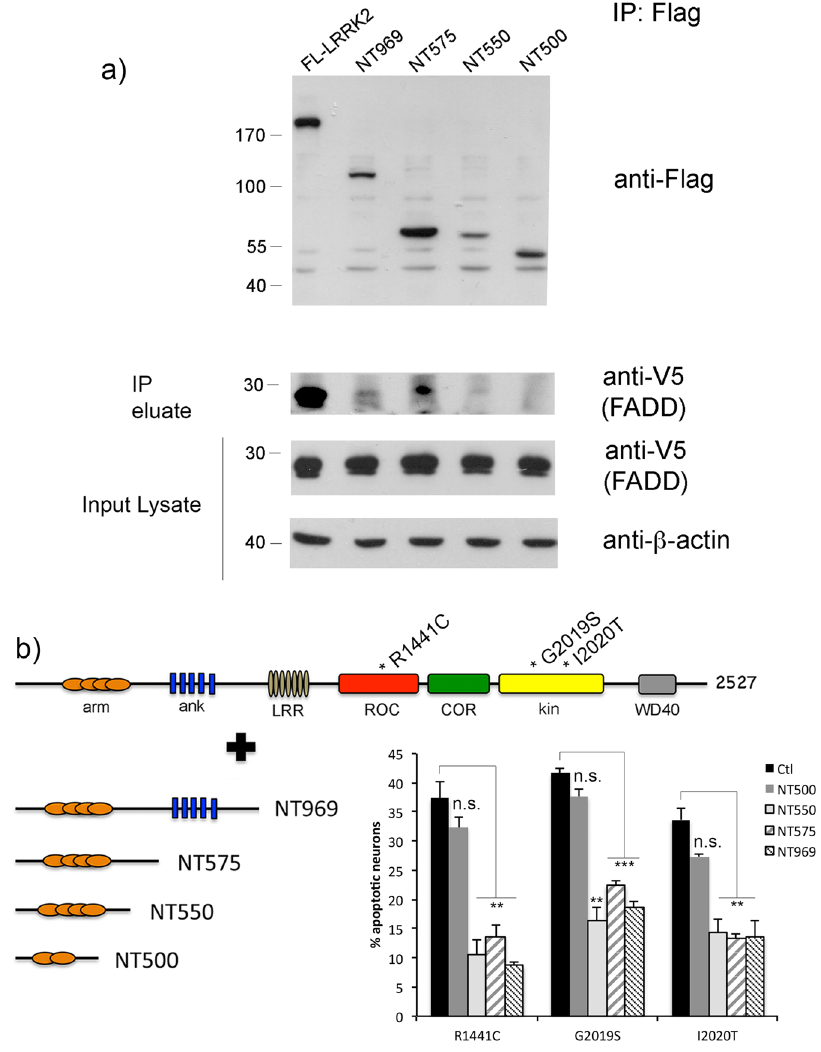
Figure 10. Fragments of LRRK2 containing FADD binding motif are neuroprotective. ( a ) HEK293T cells were co-transfected with V5-FADD and Flag-tagged full-length WT or mutant LRRK2 (I2020T); or fragments of the N-terminal domain of LRRK2 comprised of amino acids 1-500 (NT500), 1-550 (NT550), 1-575 (NT575), or 1-969 (NT969). Cell extracts were subjected to anti-Flag immunoprecipitation and the eluates were probed for the presence of co-precipitating FADD. While a fragment of the LRRK2 N-terminal domain containing amino acids 1-500 (NT500) was unable to bind FADD, increasing the length to 550 or 575 amino acids (NT500, NT575) restored the interaction with FADD, suggesting that the FADD binding motif is located within residues 500-575 of the LRRK2 N-terminal domain. ( b ) Primary cortical neurons were transiently co-transfected with full-length WT or R1441C, G2019S, or I2020T mutant LRRK2 together with the different N-terminal fragments of LRRK2 depicted in the schematic. Fixed neurons were then assessed for the presence of apoptotic nuclear features. Co-expression of the fragments of LRRK2 that interact with FADD blocked the apoptotic death of cortical neurons induced by full-length G2019S mutant LRRK2. ** p < 0.01 compared to neurons transfected with R1441C or I2020T LRRK2 and pcDNA control plasmid; *** p < 0.001 compared to neurons transfected with G2019S-LRRK2 and pcDNA control plasmid. Each data point represents the mean + / − SEM from 3–4 independent transfections. Cultures were repeated at least 3 times with similar